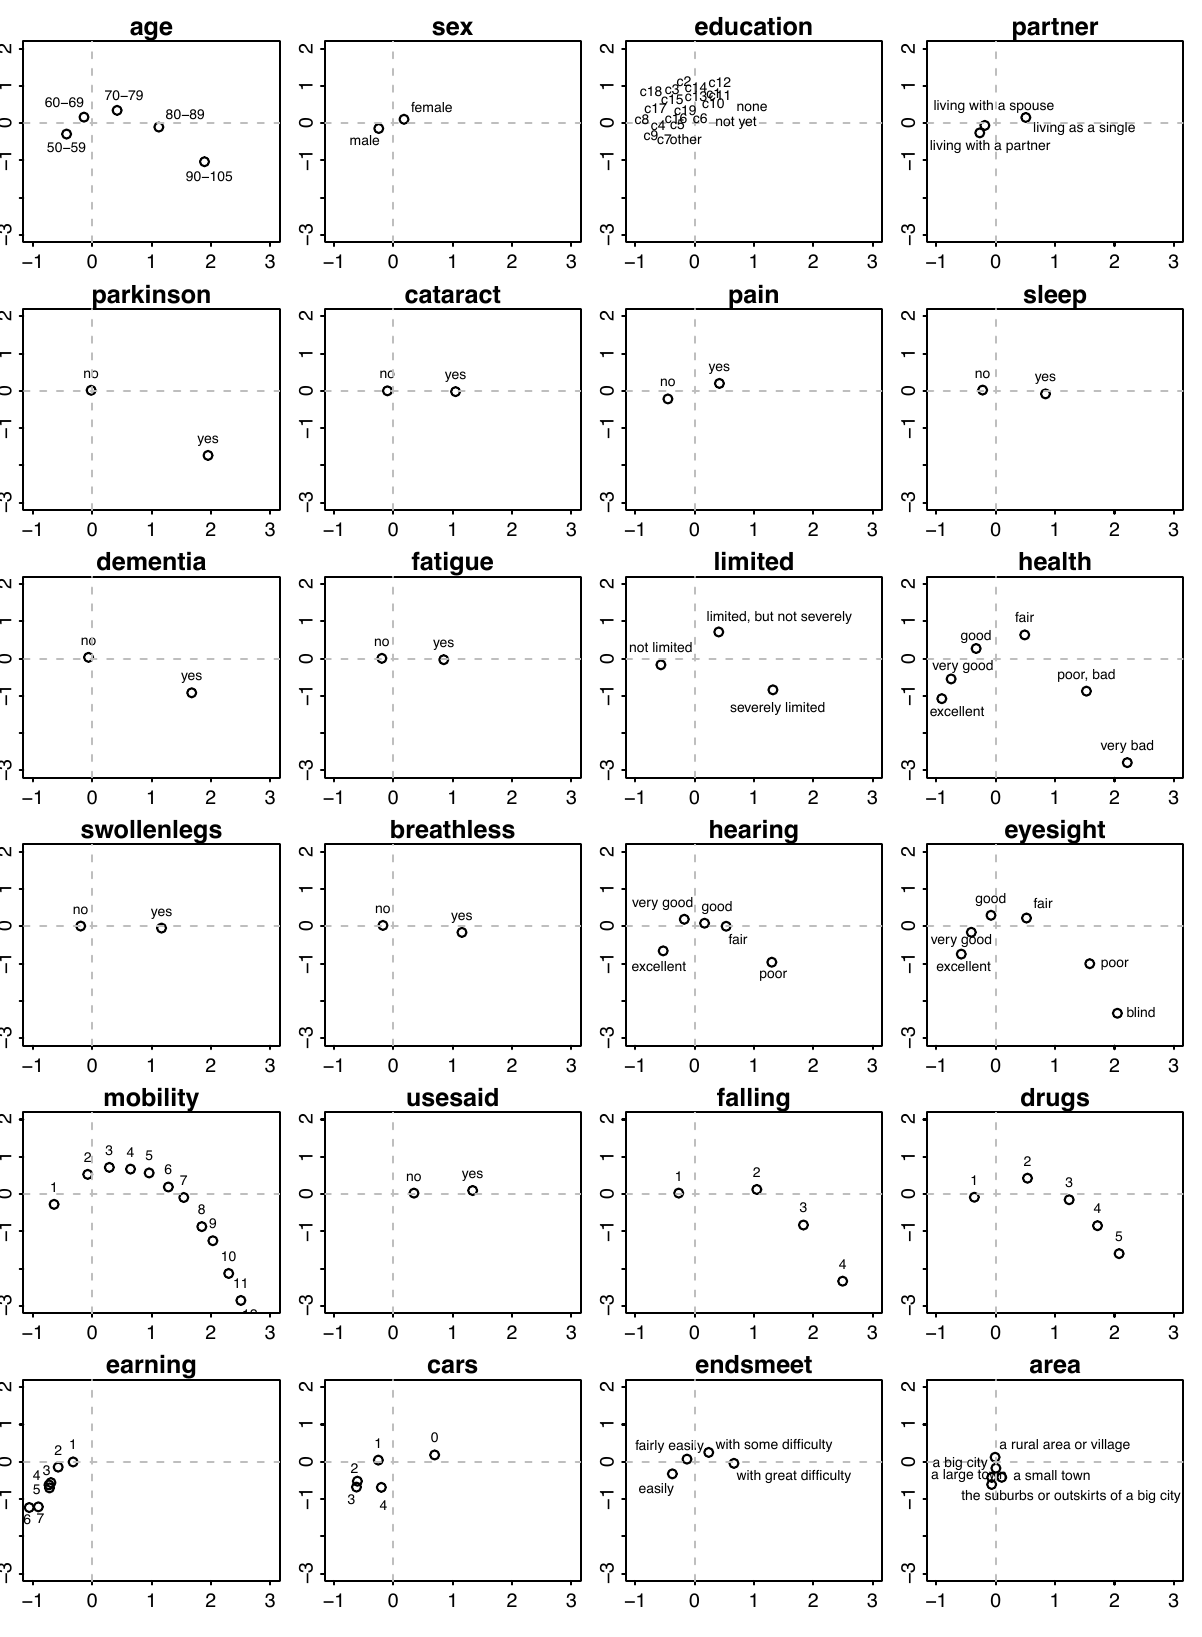
Figure 4. Category quantifications on Component 1 (horizontal) and Component 2 (vertical) per variable (side